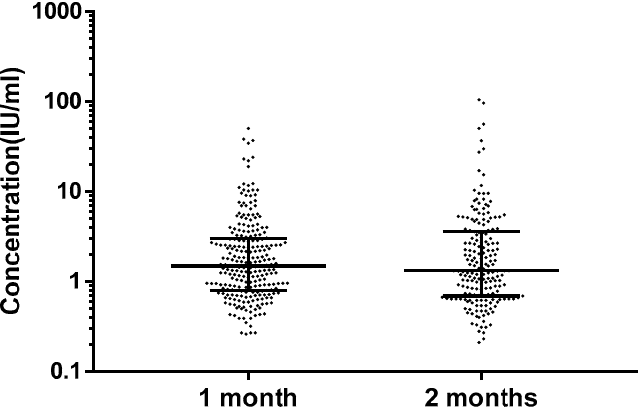
Figure 3. Serum PT IgG antibodies concentrations of one-month-old and two-month-old infants. The data are shown as median ± interquartile range. No statistical difference was observed between the two groups ( p = 0.56).